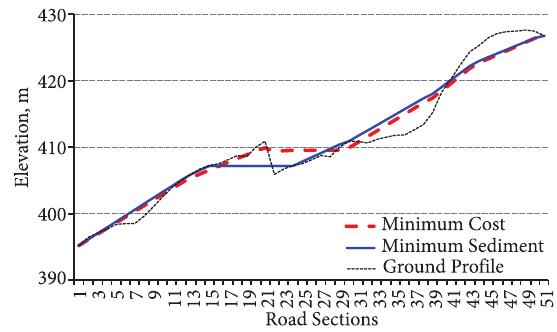
Fig. 4. Ground profile and road profiles for both design scenarios Table 2. Main cost components for two road design scenarios